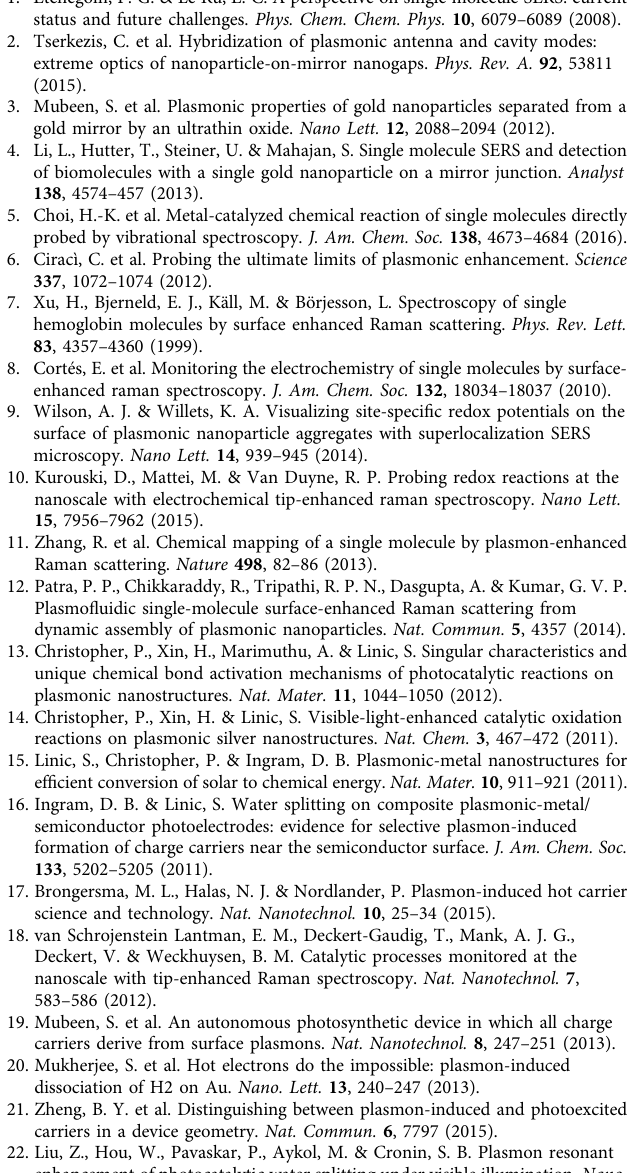
Simulations . DFT . For Raman and density of states simulations, molecular structures are pre-optimised using the Merck Molecular Force Field (MMFF94), with the main optimisation performed by the Gaussian09 package. Vibration spectra are calculated using the hybrid B3LYP/6-31G(p) functional using the CPCM solvation model for water. A scaling factor of 0.975 is used. FDTD (Finite-Difference Time-Domain) . Three-dimensional numerical simulations are carried out using Lumerical FDTD Solutions v8.12. The Au NP is modelled as a sphere of diameter 80nm on top of an in fi nite dielectric sheet of